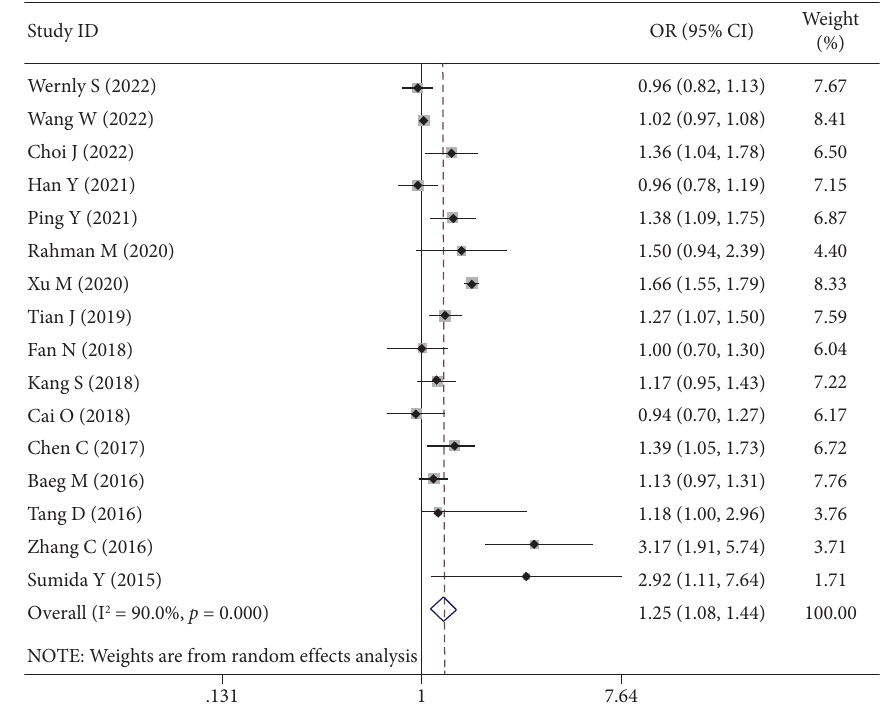
Figure 3: Forest plots for adjusted data from cross-sectional studies and case-control